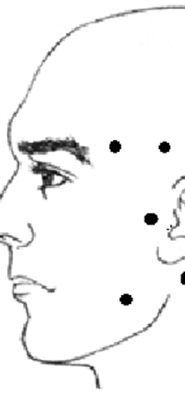
Figure 2. PPT measurement points.